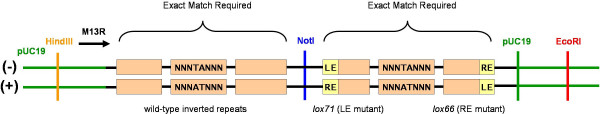
Sequence features of a typical read. Sequence was generated from the negative strand with the M13 Reverse primer (M13R). Exact matches to the wild-type and lox71 and lox66 inverted repeat mutants were required for spacers to proceed to further analysis. The NotI site, pUC19 vector boundary and EcoRI were also detectable. The HindIII site could not be detected with the M13 Reverse primer.